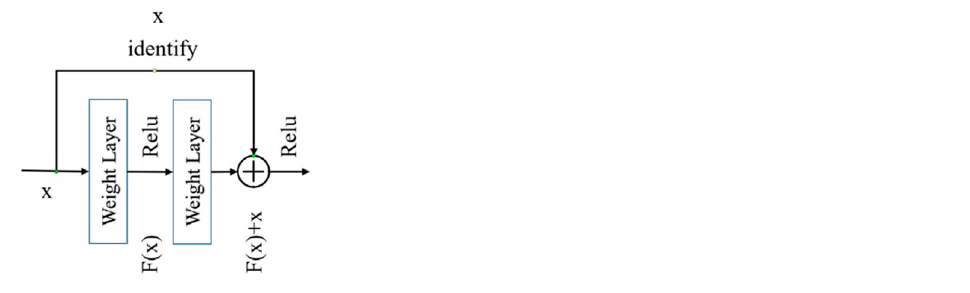
Figure 7. The mechanism of a sample residual block (adapted from Figure 2 in [33]).